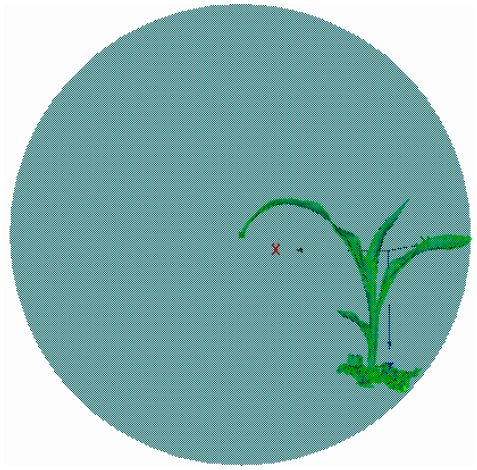
Figure 6. Calculation method for canopy breadth based on the fitting sphere.